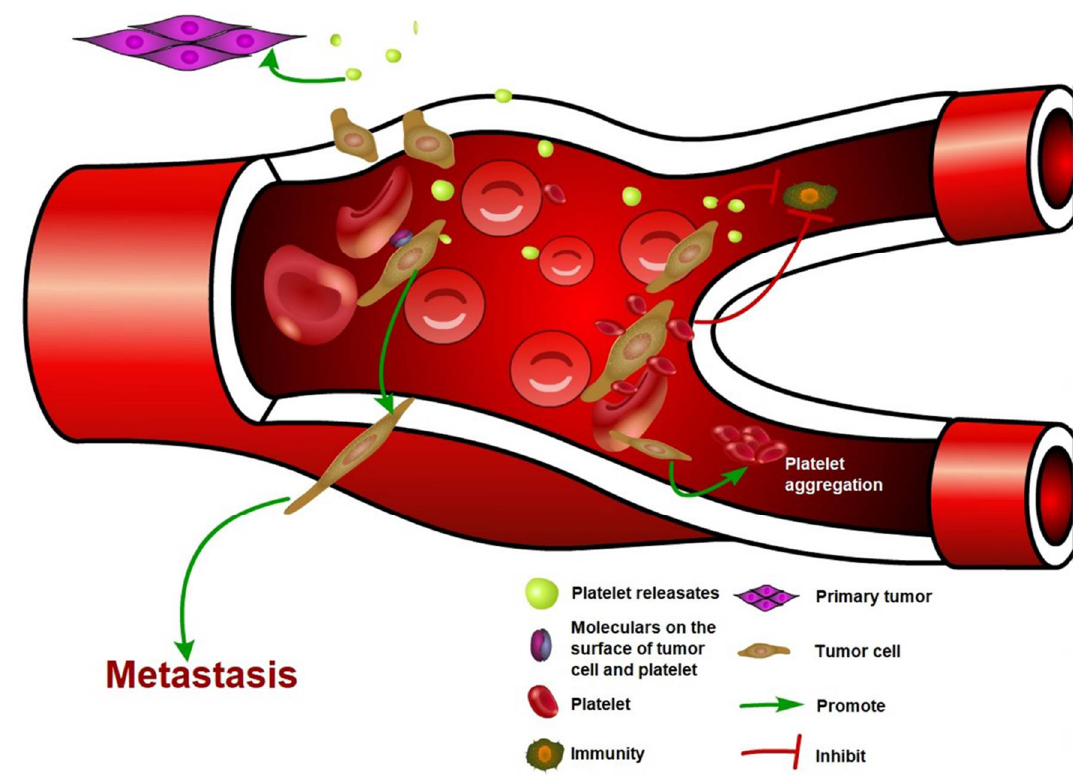
Figure 1. The interaction between cancer cell and platelet. Circulating tumor cells induce platelet activation and aggregation. Activated platelets release a variety of factors, which promote primary tumor growth and cancer metastasis. Binding of platelets also protects CTCs from flow shear force and immune cell attacks.